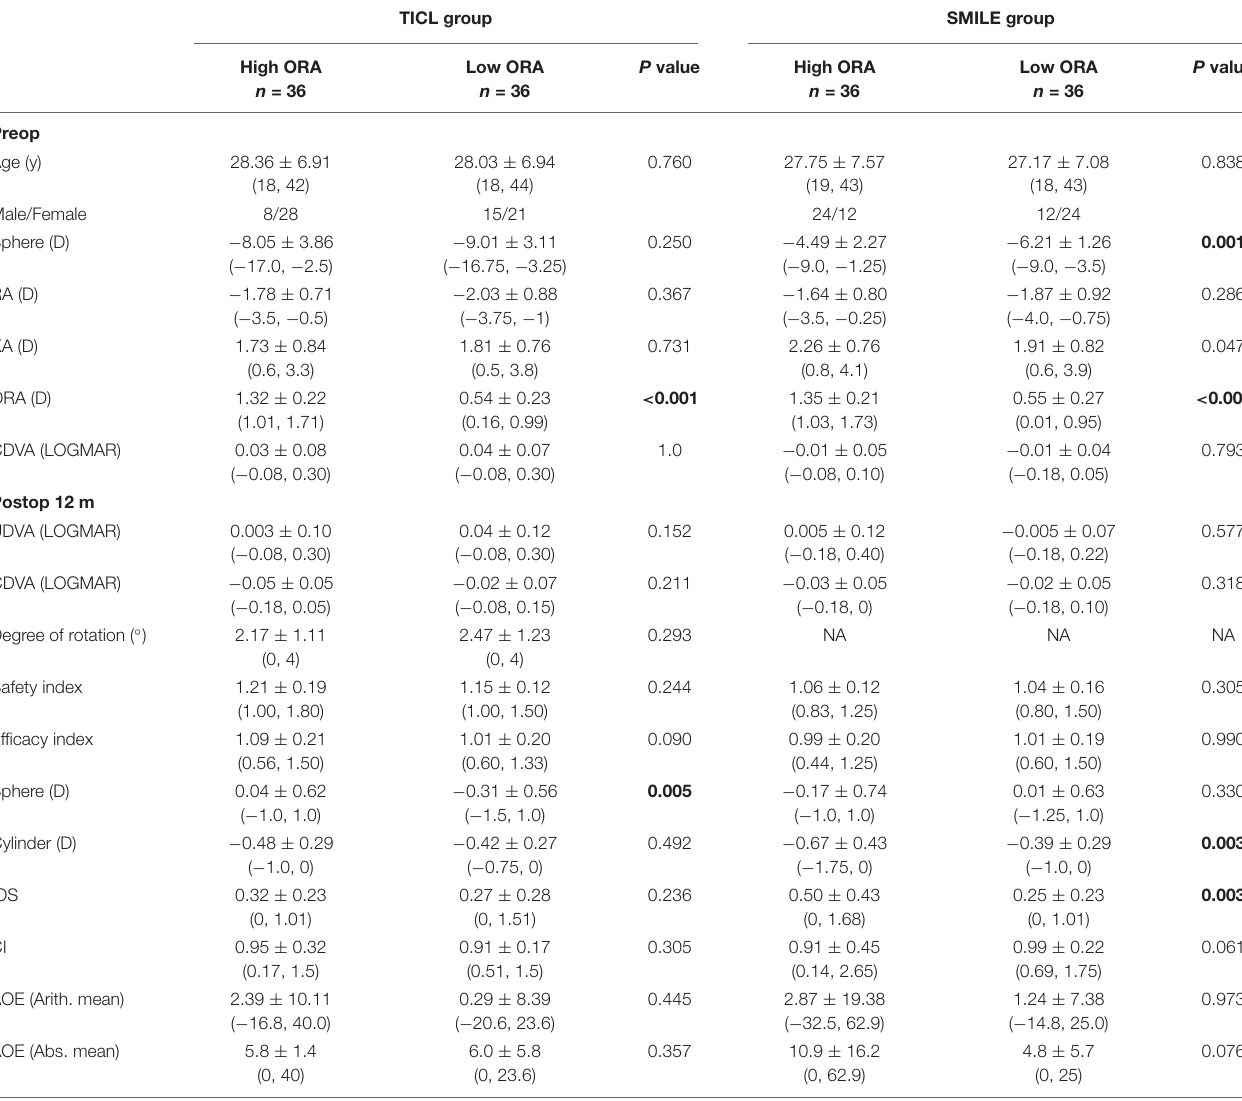
TABLE 1 | Comparisons between TICL and